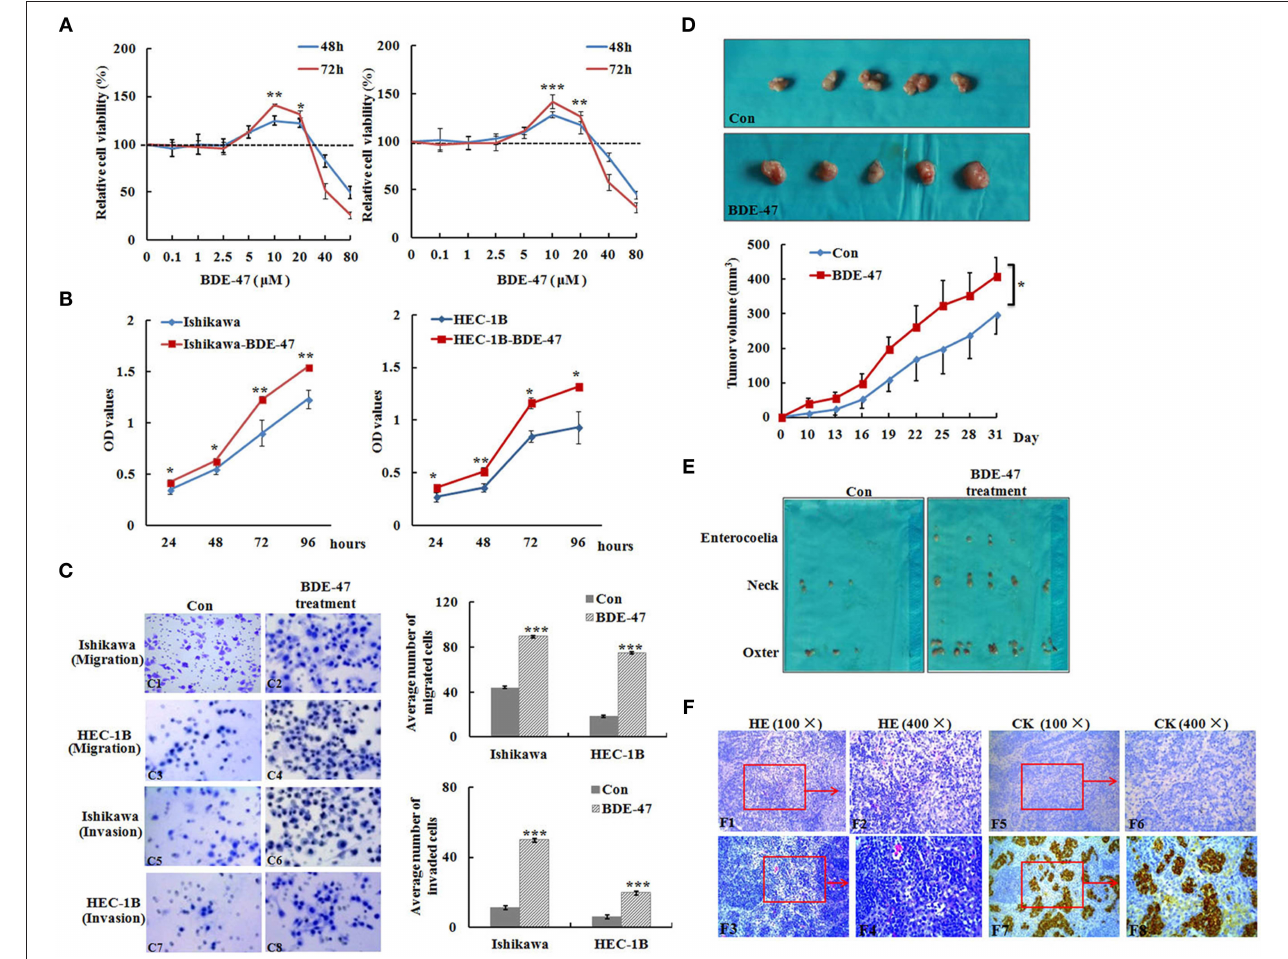
FIGURE 1 | Effect of BDE-47 on the viability and metastasis of EC cells. (A) MTT assay on Ishikawa (Left panel) and HEC-1B (Right panel) cells treated with BDE-47 at the concentrations of 0.1, 1, 2.5, 5, 10, 20, 40, and 80 µ M for 48 and 72h. (B) OD values reflecting the viability capacity of Ishikawa (Left panel) and HEC-1B cells (Right panel) recorded at 24, 48, 72, and 96h after cells were exposed to BDE-47 at 10 µ M for 45 days. (C) Cell migration (C1–C4) and invasion (C5–C8) assay on Ishikawa/Ishikawa-BDE-47 and HEC-1B/HEC-1B-BDE-47 cells. Representative images (400 × ) of cell migration (C1–C4) and invasion (C5–C8) are shown on the left side. (D) Primary xenograft tumors of Ishikawa cells and tumor volumes. (E) Lymph nodes containing potential metastasis from mice were found and shown. (F) Upper panel: HE staining assessed cellular morphology of lymph nodes with or without metastatic tumors. F1: 100 × , F2: 400 × , F3: 100 × , F4: 400 × ). Lower panel: IHC staining of cytokeratin negative in F5 (100 × ) and F6 (400 × ), and positive in F7 (100 × ) and F8 (400 × ). CK, Cytokeratin; Con, Ishikawa cells without BDE-47 treatment. * P < 0.05; ** P < 0.01; *** P < 0.001.